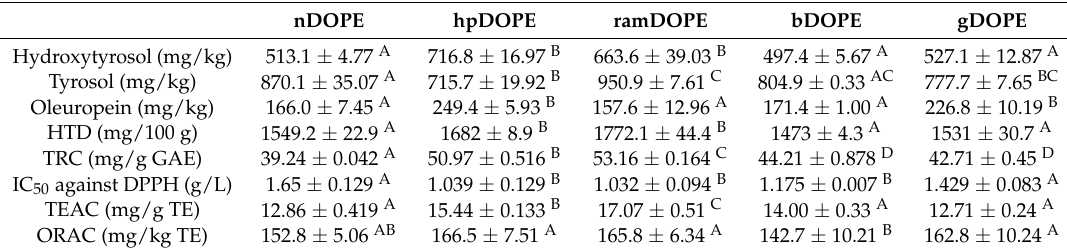
Table 2. Impact of cyclodextrins on the content of hydroxytyrosol derivatives and chemical antioxidant activity of olive pomace